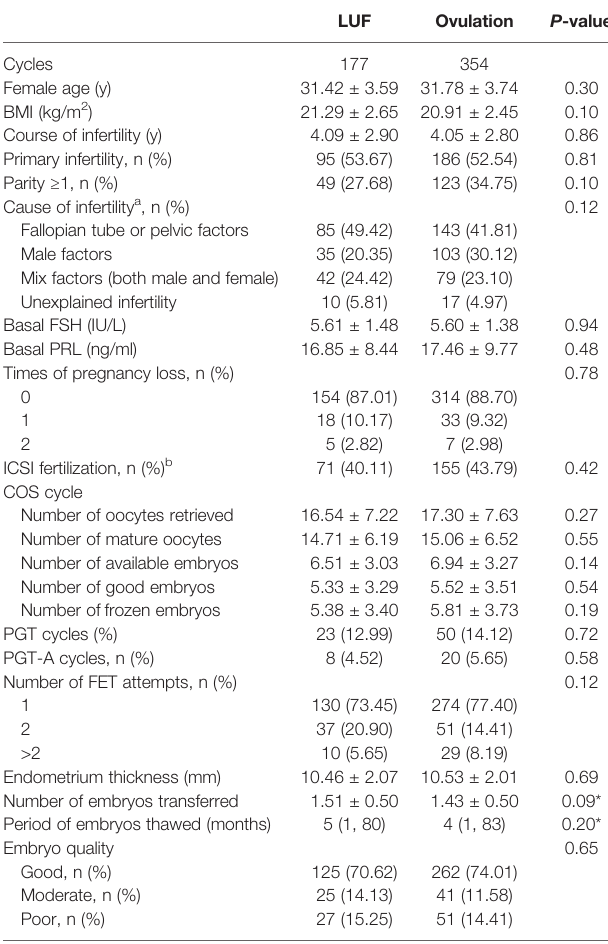
TABLE 1 | Baseline characteristics between the LUF group and ovulation group.